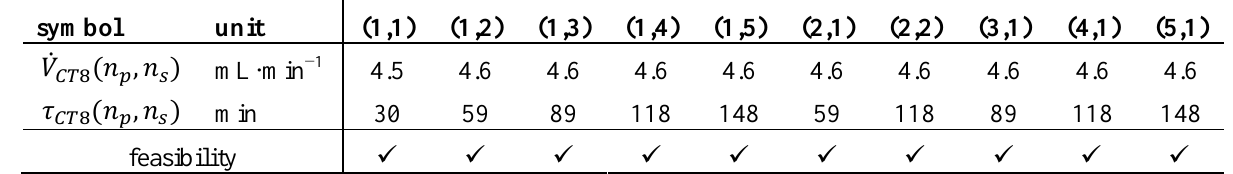
Table 5. Results for CT8 after residence time criterion.